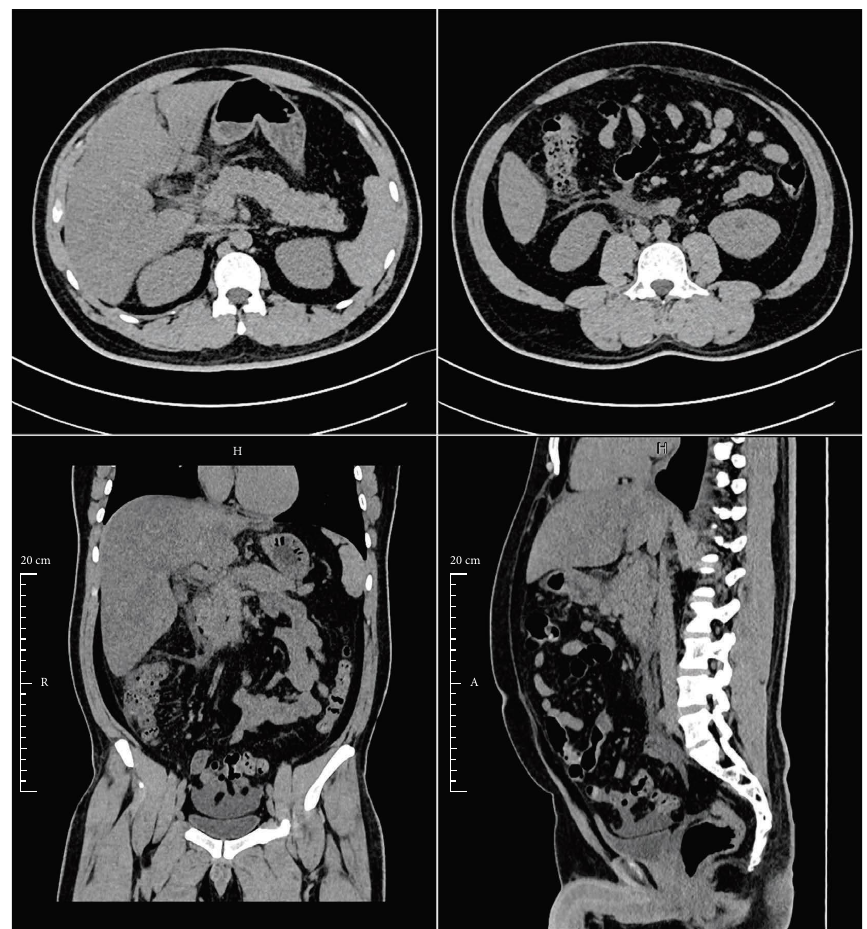
Figure 1: Noncontrast abdominal CT showing an enlarged pancreas, peripancreatic fat stranding, and peripancreatic fuid collection, consistent with Balthazar score